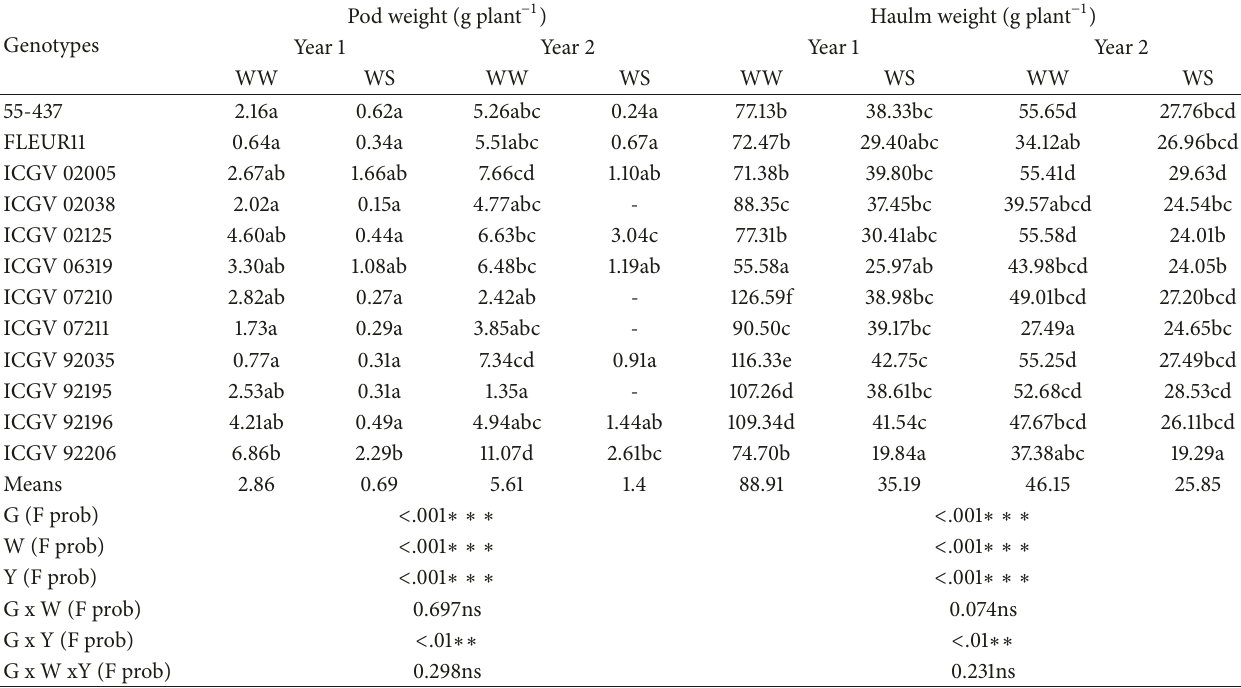
Table 1: Pod and haulm weight of groundnut genotypes under well-watered (WW) and water-stressed (WS) treatments in 2017 (year 1) and 2018 (year 2). G= genotypes, W = water regimes, and Y= year. ∗ = significant at 5% level. ns = not significant at 5% level. Means with the same letter are not significantly different within the same treatment by Duncan’s multiple range